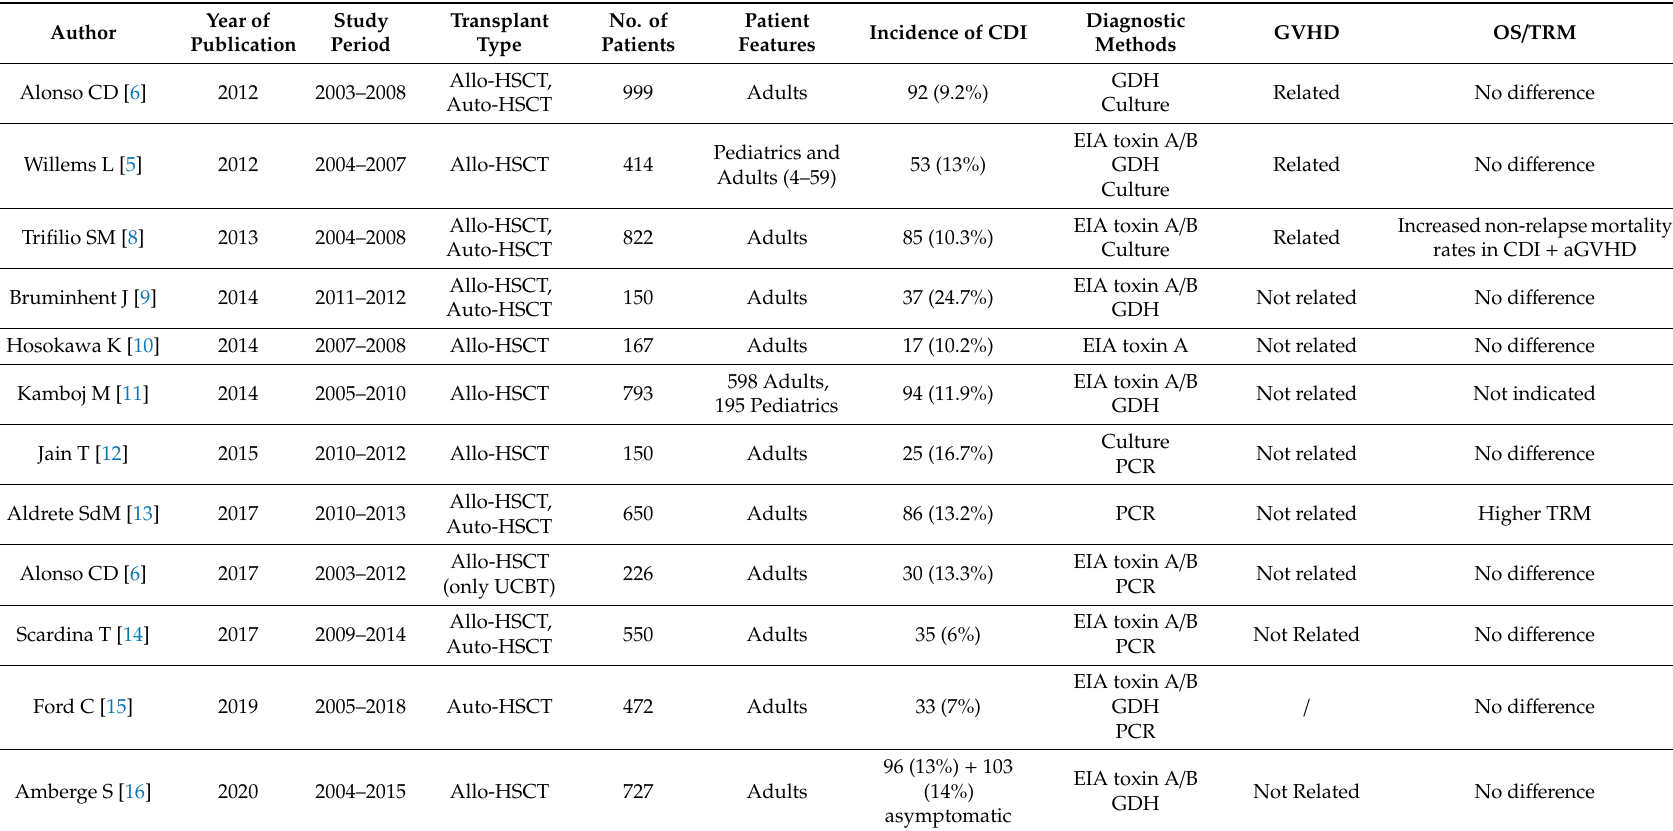
Table 1. Clinical results reported in previously published